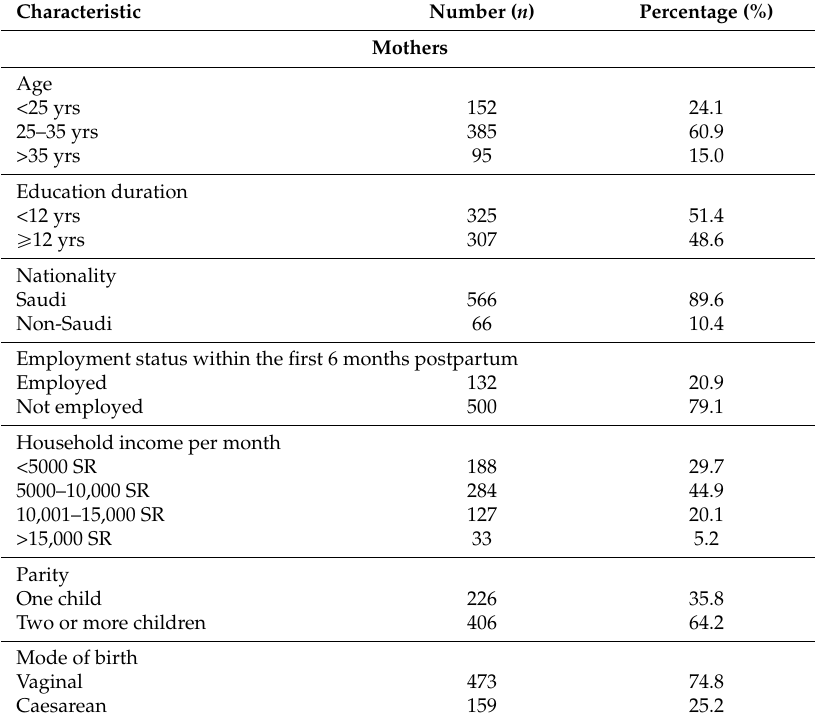
Table 1. Characteristics of the study population ( n =